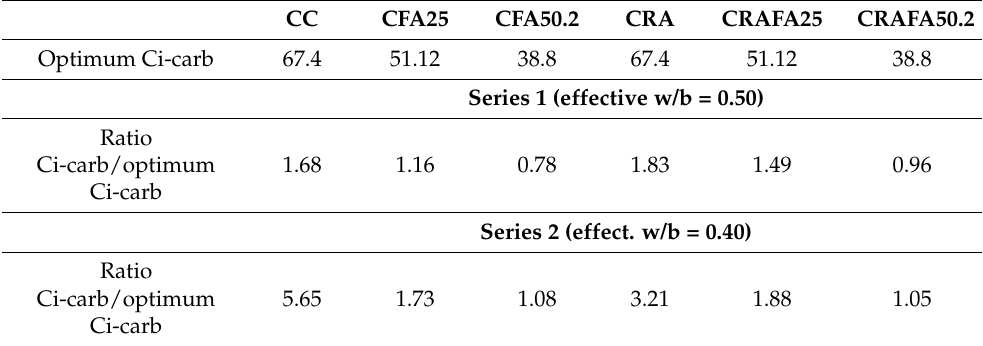
Table 6. The optimum Ci-carb values of each concrete and the ratios of the obtained results with respect to the optimum results.